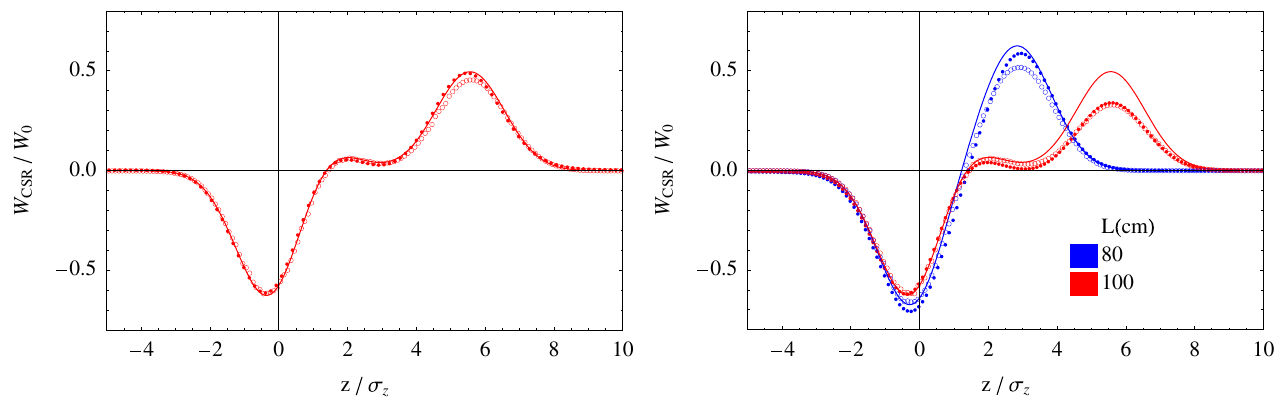
FIG. 9. (Color) Left: The transient case using parameter set B with a relatively large chamber. Right: Set C with a smaller chamber (right). A&Y code (dots), and Bmad (circles), are generally in good agreement. The CSR-wake formula Eq. (47) (lines), which does not take into account shielding, agrees in the former case but shows differences in the latter.